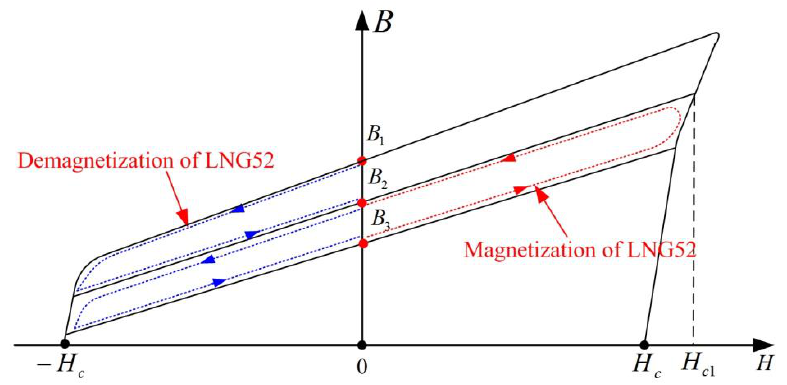
Figure 5. Magnetization and demagnetization of LNG52.